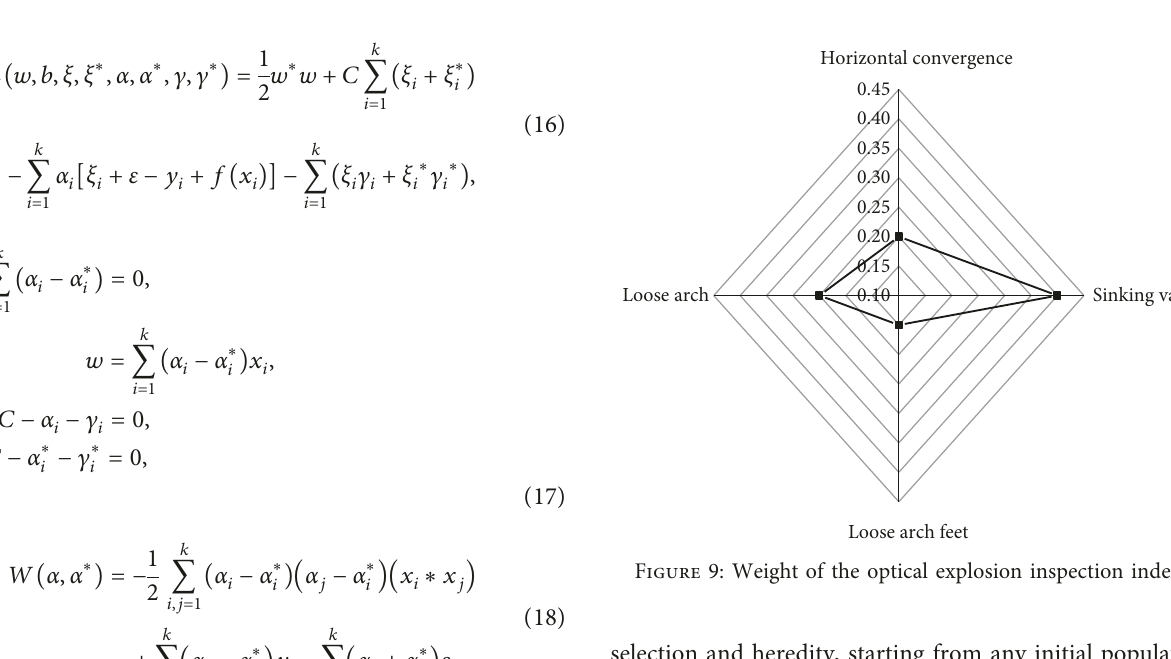
Figure 8: Verification of optical explosion experimental results. (a) Eye spacing and (b) variation value.